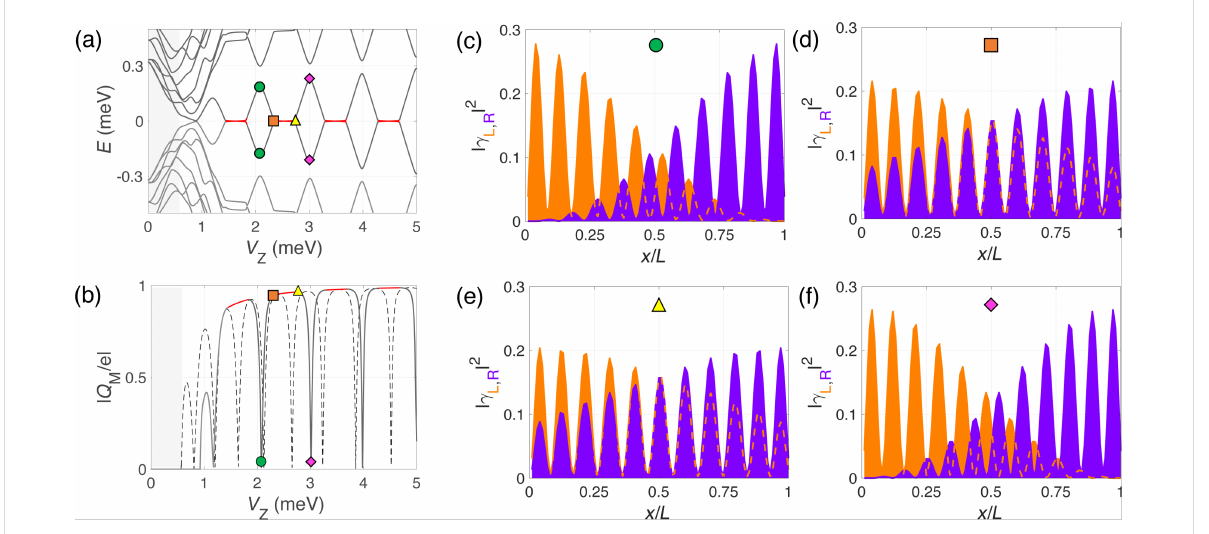
Figure 4: Same as Figure 3 but for the interacting case (without leads). In the pinned regions the Majorana wave functions remain in-phase as a func- tion of the Zeeman field and the Majorana charge (b) freezes at its local maximum value (in red), instead of continuing the oscillation as in the non- interacting case (dashed